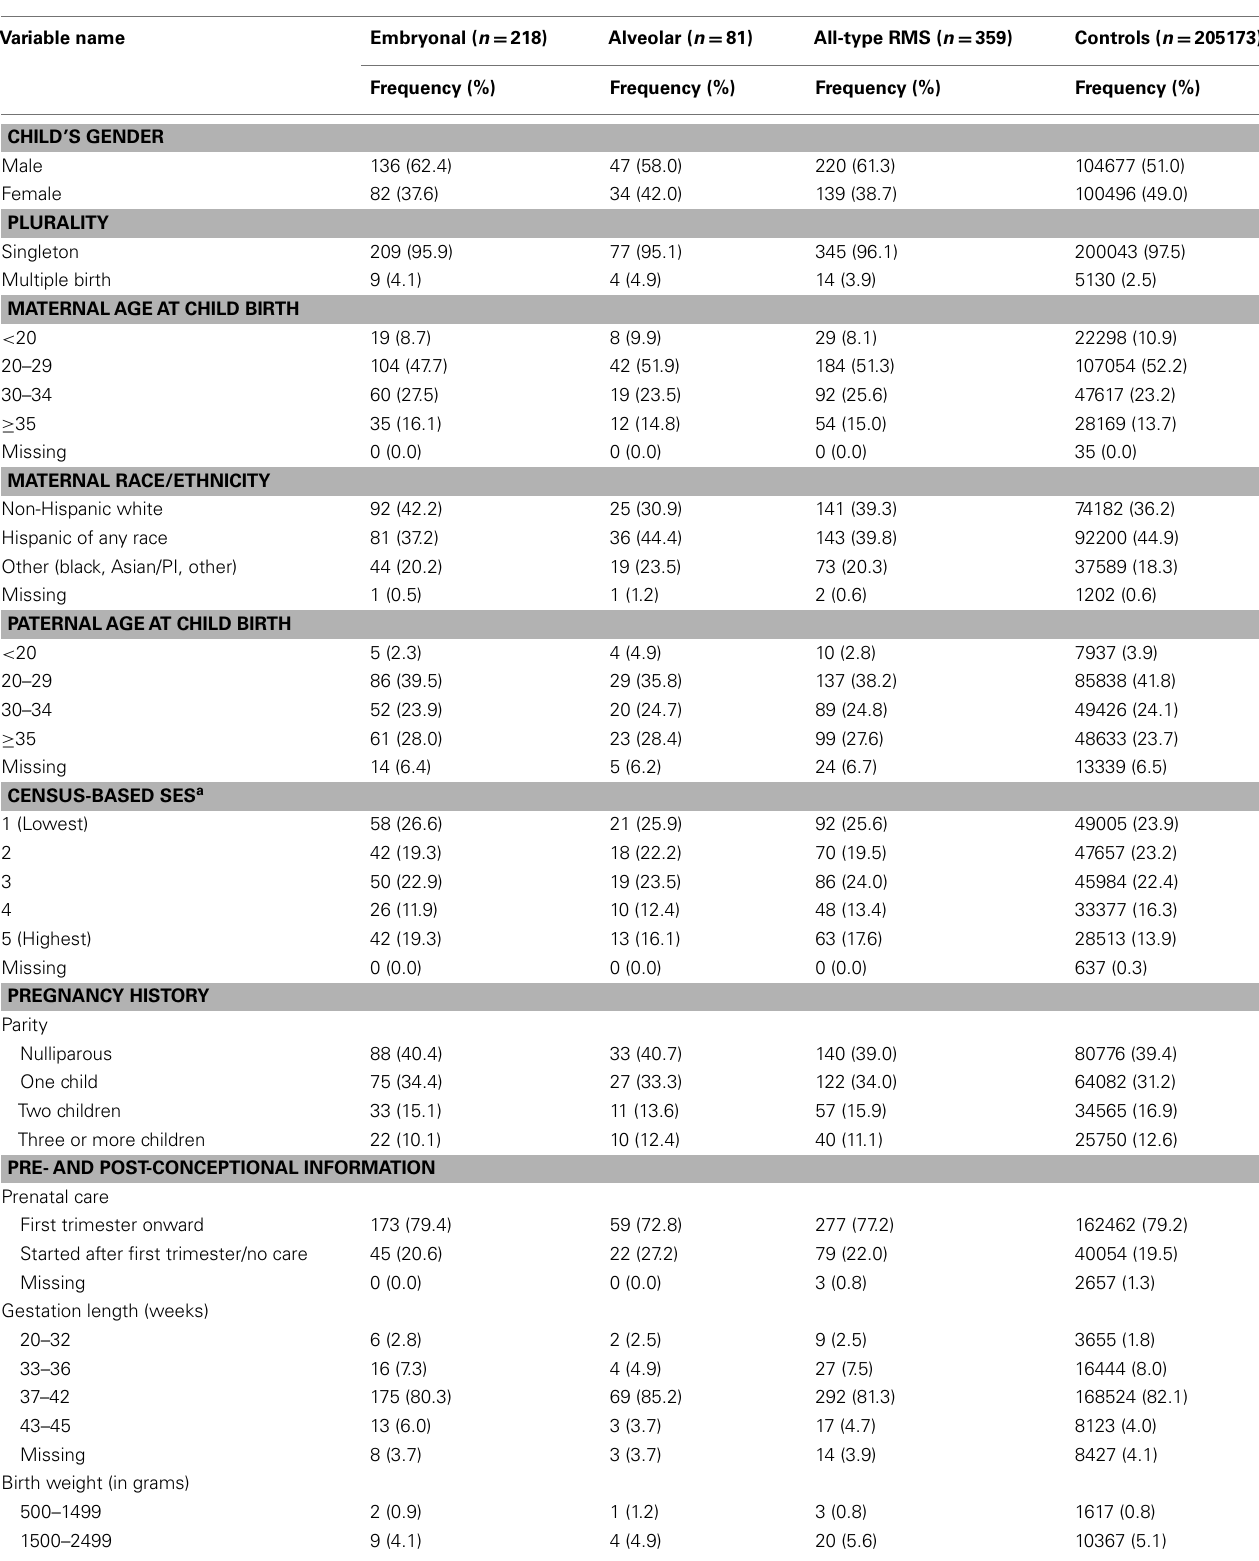
Table 1 | Frequency distribution of demographic and perinatal characteristics across cases and